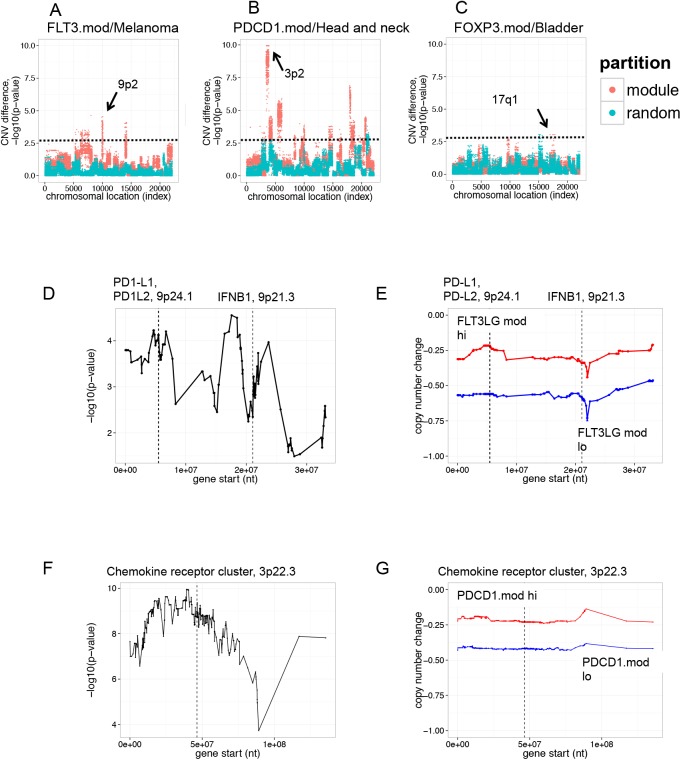
T cell infiltrates are associated with distinct genetic alterations in different tumor types.The significance (Wilcoxon p-value) of copy number differences between groups of T/NK module module hi and module lo tumors were determined for all genes in the genome. Shown are Manhattan plots for p-values (y axis) for all genes, arranged in ascending order (left to right) by chromosomal start position (x axis). Horizontal dashed lines denote significance cut-off of p-value = 1e-3. Arrows indicate regions of highest significance. Red, samples partitioned by module expression; teal, samples partitioned randomly. A) Melanomas partitioned by expression of T/NK cell module, FLD3LG.mod, showed significant copy number differences at chromosome 9p21. B) Head and neck tumors partitioned by expression of T cell module, PDCD1.mod, showed significant copy number differences at chromosome 3p22. C) Bladder tumors partitioned by expression of T/NK cell module, FOXP3.mod, showed significant copy number differences at chromosome 17q21. D) Significance of copy number differences between FLT3LG.mod hi and FLT3LG.mod lo tumors in melanoma across a large region of chromosome 9p2. Shown is an enlarged view of the significance of copy number difference in genes on chromosome 9p2. Dashed vertical lines indicate positions of IFNB1 and PD1-L1/PD2-L2 gene loci. For reference, the IFNB1 gene begins at chromosome 9 nucleotide 21,077,104, and PD-L2 at nucleotide 5,510,545. E) Copy number loss at 9p2 in FLT3LG.mod lo versus FLT3LG.mod hi melanomas. Shown is an enlarged view of median copy number change for genes on chromosome 9p2 in melanoma. Blue, FLT3LG.mod lo tumors (poor prognosis); Red, FLT3LG.mod hi tumors (good prognosis). F) Significance of copy number differences between PDCD1.mod lo and PDCD1.mod hi head and neck tumors across a region of chromosome 3p. Dashed vertical lines indicate the location of a cluster of chemokine receptor genes. G) Copy number loss at 3p2 in head and neck tumors. Blue, PDCD1.mod lo tumors (poor prognosis); Red, PDCD1.mod hi tumors (good prognosis).